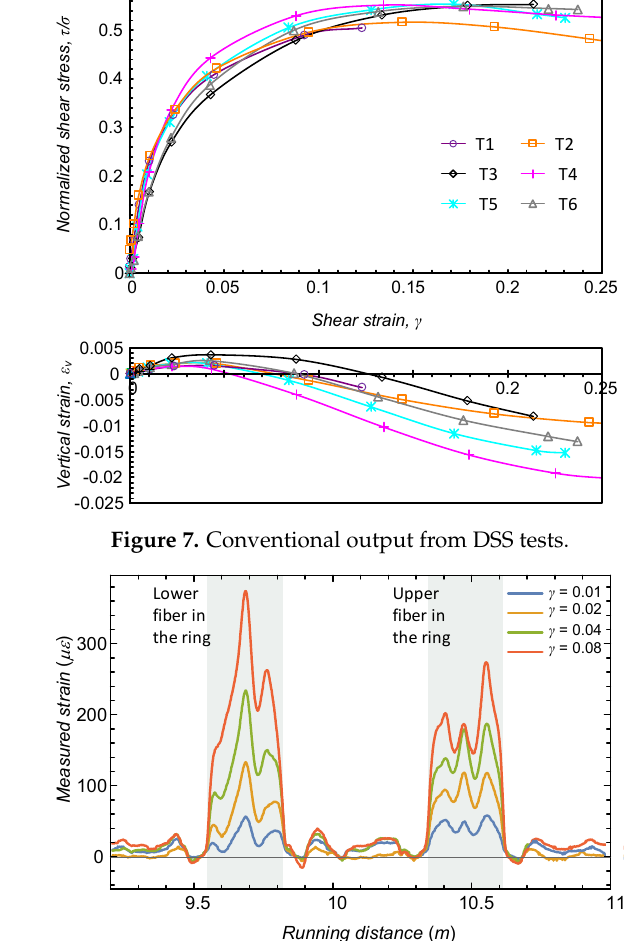
Figure 8. Example of raw measurements along the optical